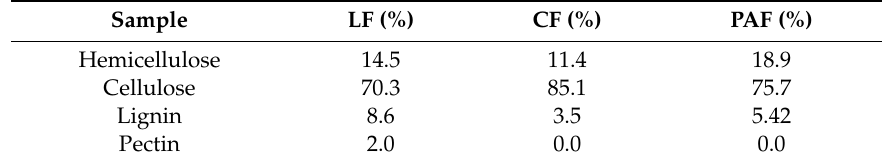
Table 1. Composition (%) of the raw linen fiber with di ff erent chemical treatments. (Each assay was run in duplicate and was repeated if the standard error exceeded